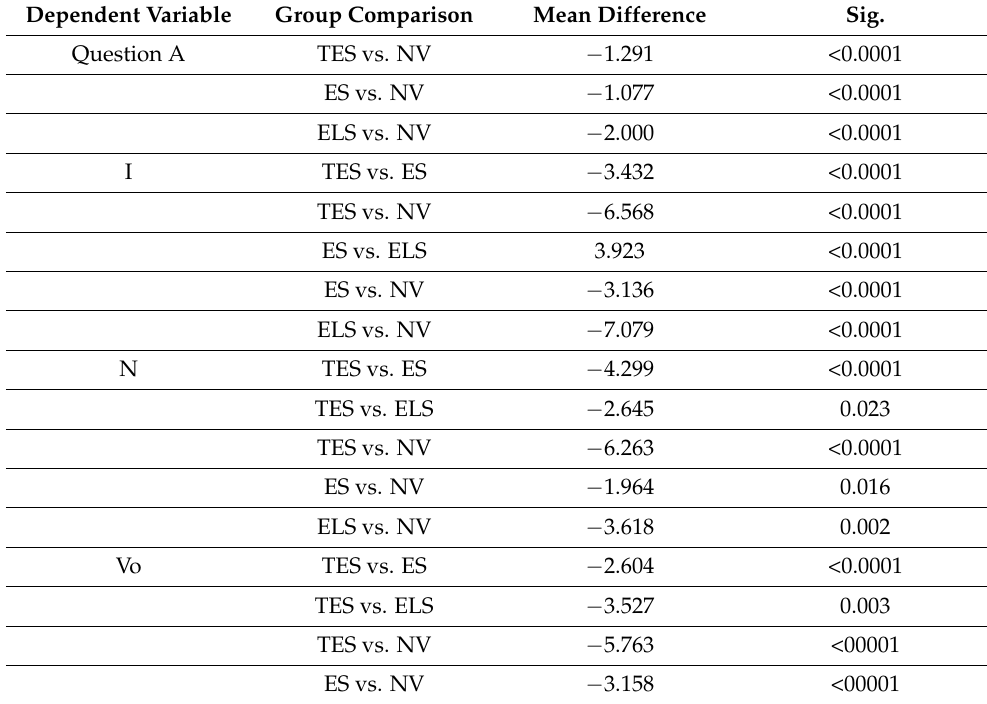
Table 5. Multiple comparisons of Bonferroni’s test of mean difference of Question A, I, N and Vo. Dependent